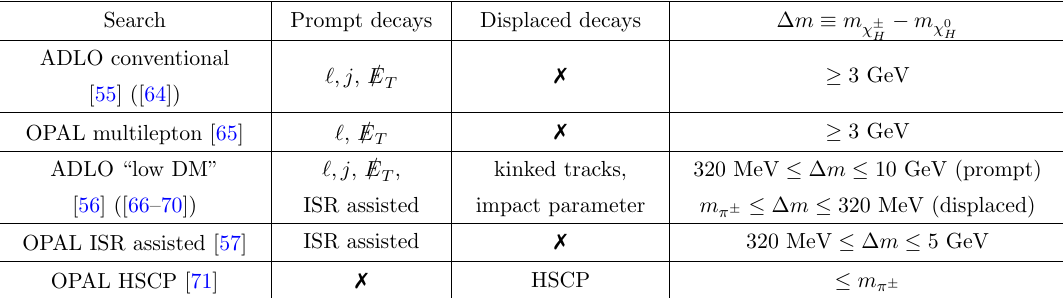
Table 1 . Summary of LEP limits used in this work, and the topologies considered within each reference. Above, ‘ stands for leptons ( e; (cid:22); (cid:28) ), j for jets, ISR for initial state radiation (of a photon), and HSCP for heavy stable charged particles. The searches included in the ADLO combination are speci(cid:12)ed in parentheses. They include a combination of the analyses using a subset of the full dataset, up to 2001, for conventional searches and using the full dataset, up to 2002, for \low